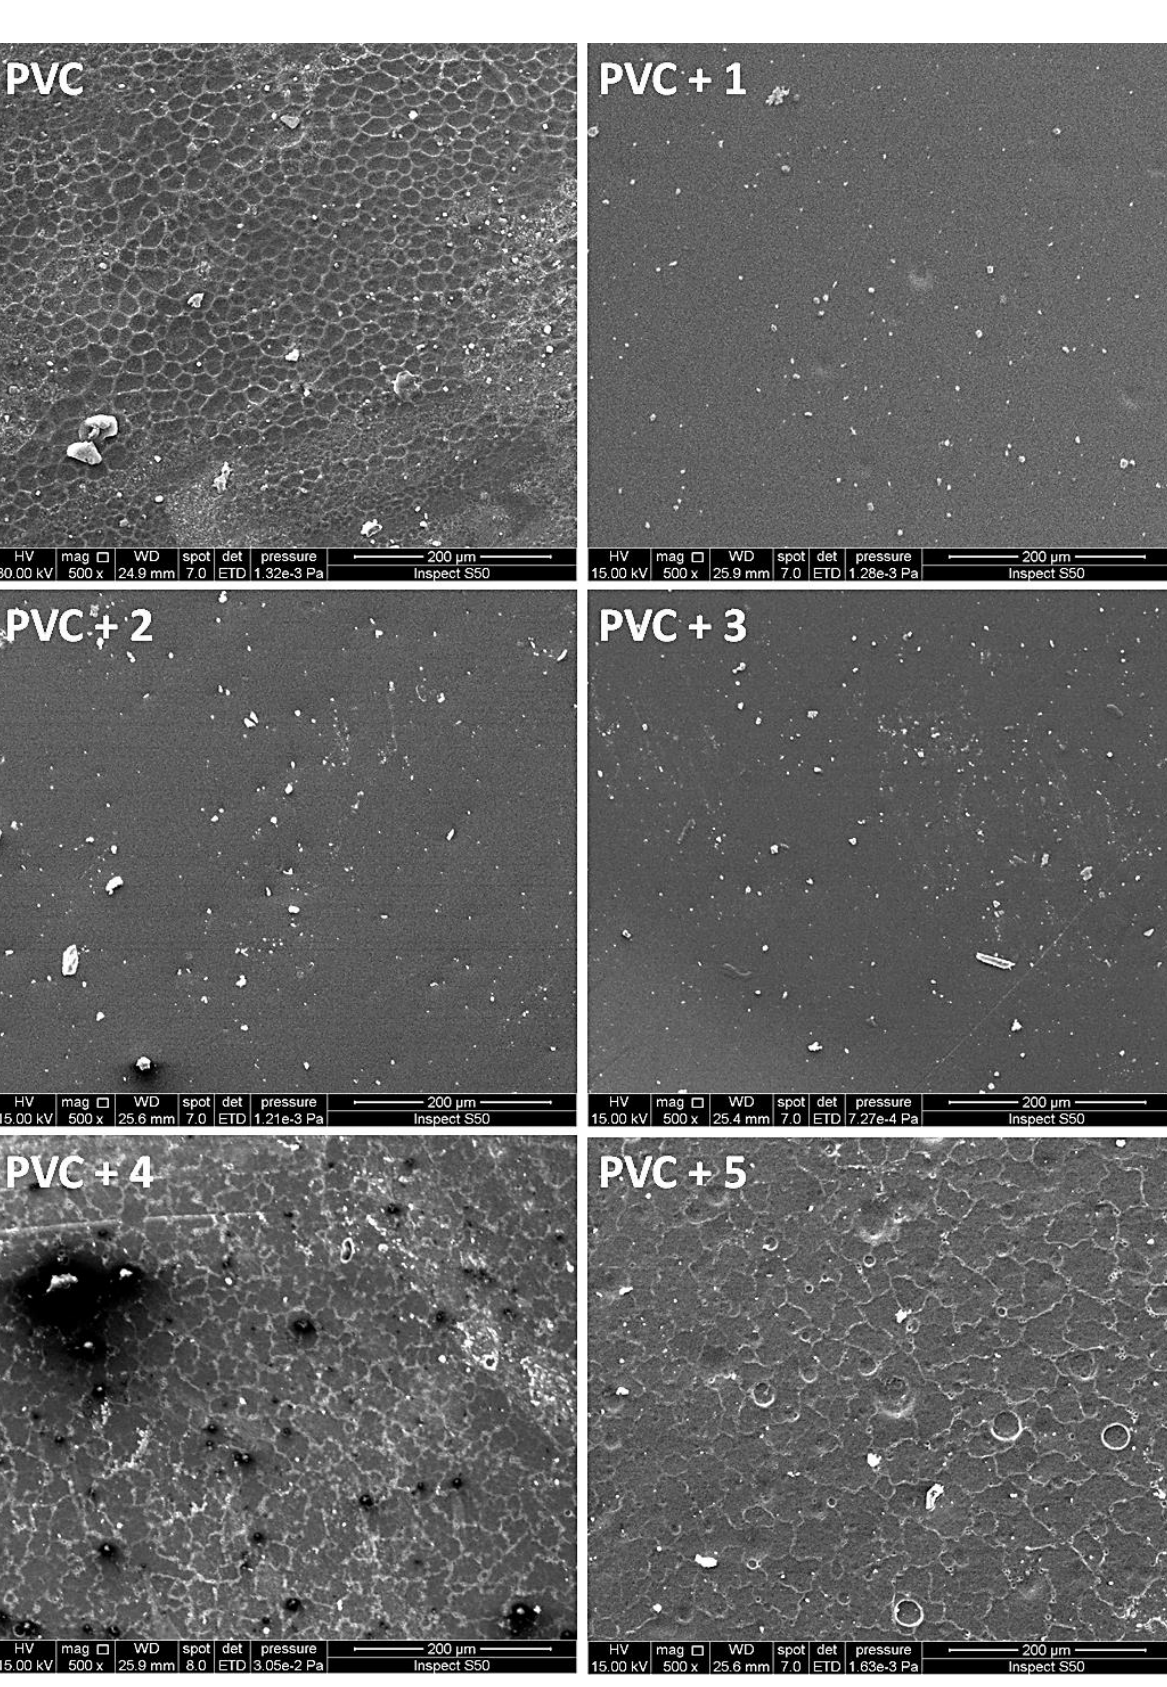
Figure 10. SEM images of the irradiated PVC films.